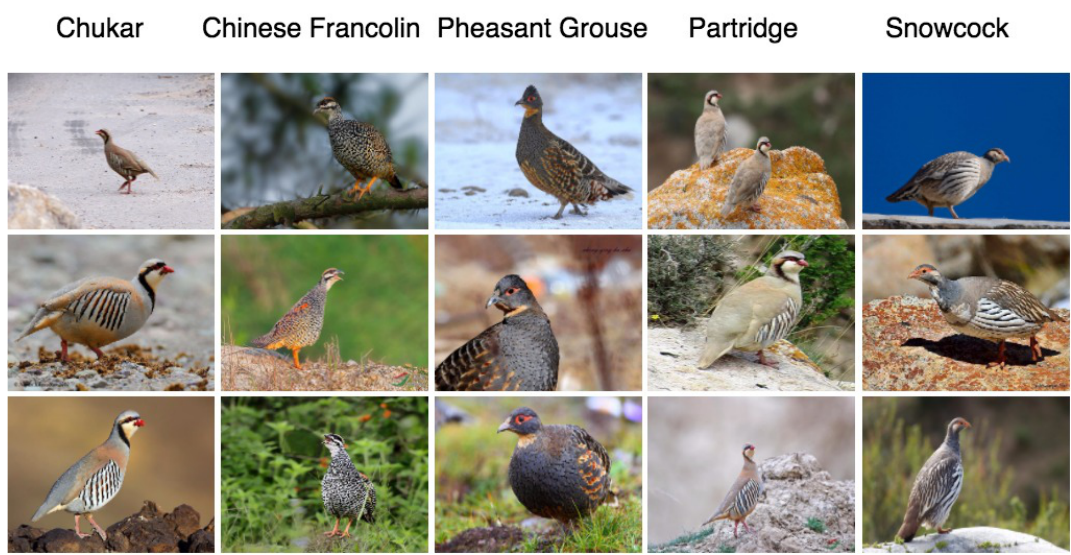
Figure 1. Images sampled from Birds-1096. Three images were randomly selected in each category (column). CUB200-2011: This dataset is the most widely used dataset for fine-grained image classification. It contains 11,788 images of 200 bird subcategories and is divided into 5994 images for training and 5794 images for testing [15]. Each subcategory consists of 30 images for training and 1130 images for